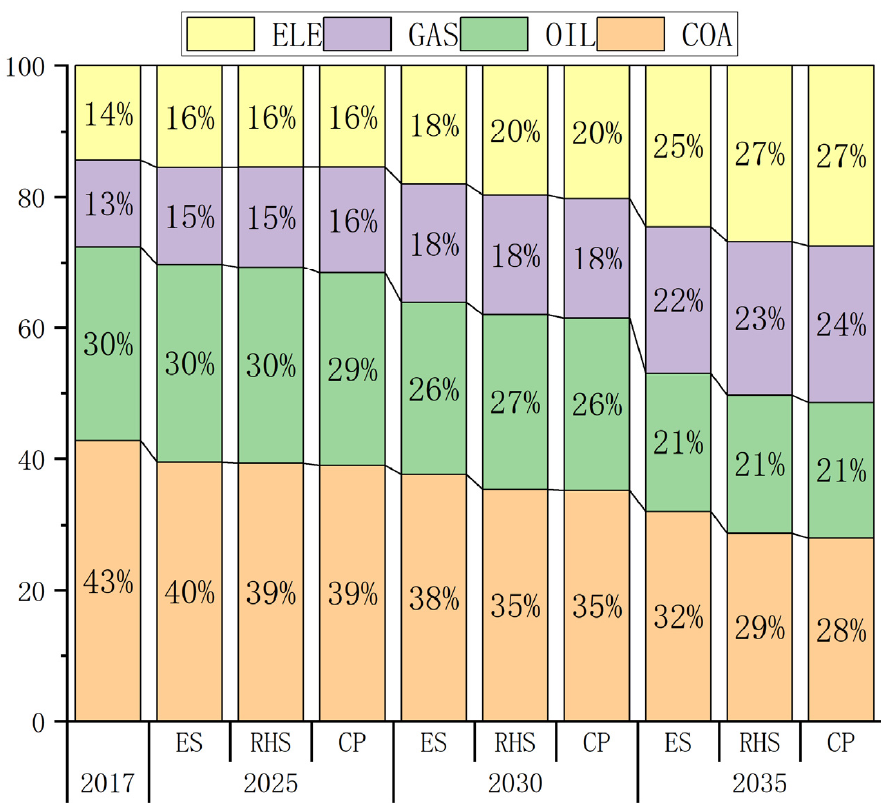
Figure 5. changes in energy structure under different scenarios. Figure 5. Changes in energy structure under different